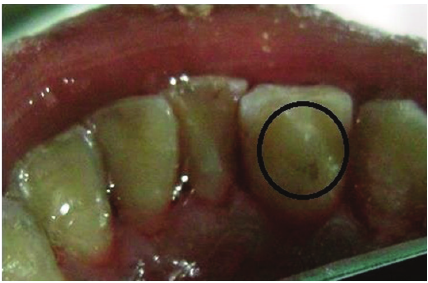
Figure 2: Clinical picture showing the talons cusp with foramen ceacum in relation to 32.